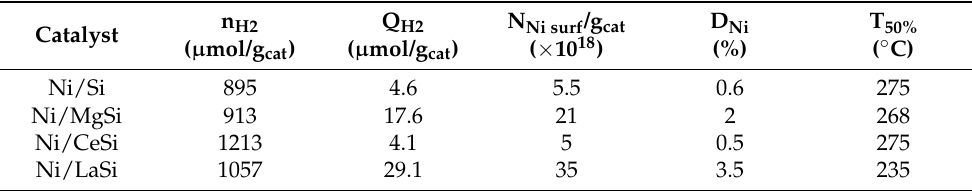
Table 2. Active metallic centers for hydrogen chemisorption and catalytic activity